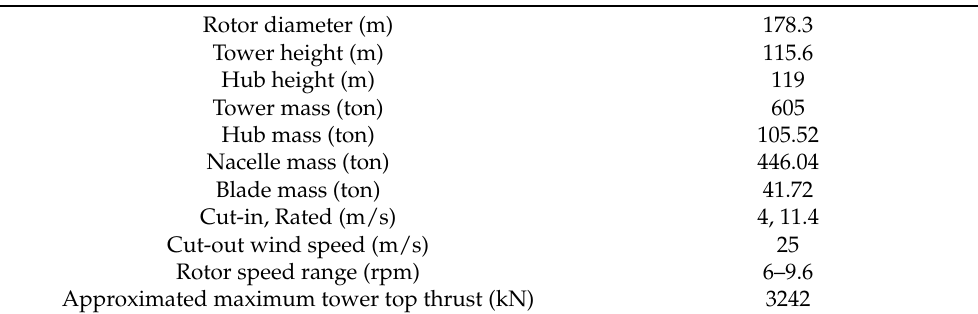
Table 2. Main dimensions of the wind turbine (taken from [25]).